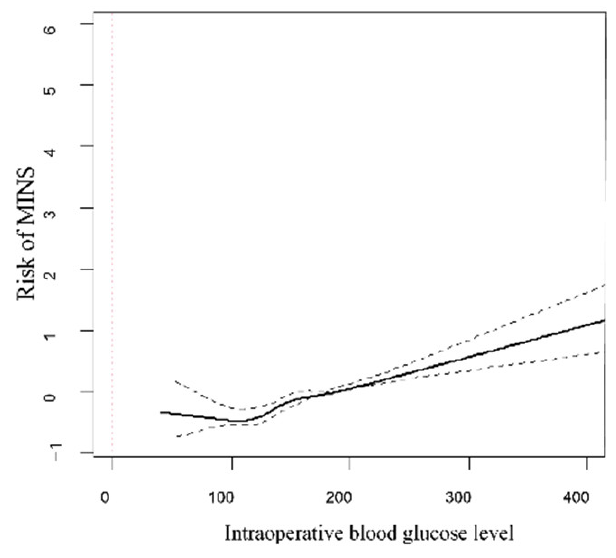
Figure 3. Spline curve for the log odds ratio of intraoperative blood glucose level versus risk of MINS.